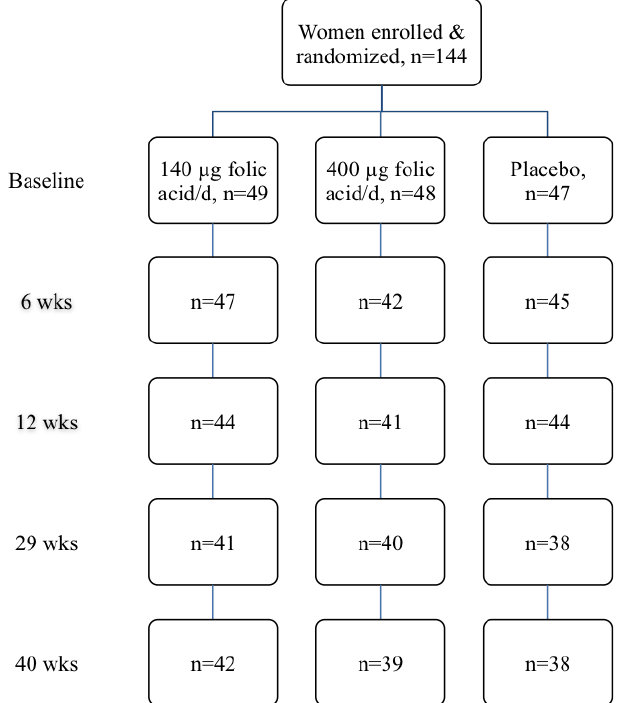
Figure 1. Flow diagram of the women who participated in the randomised